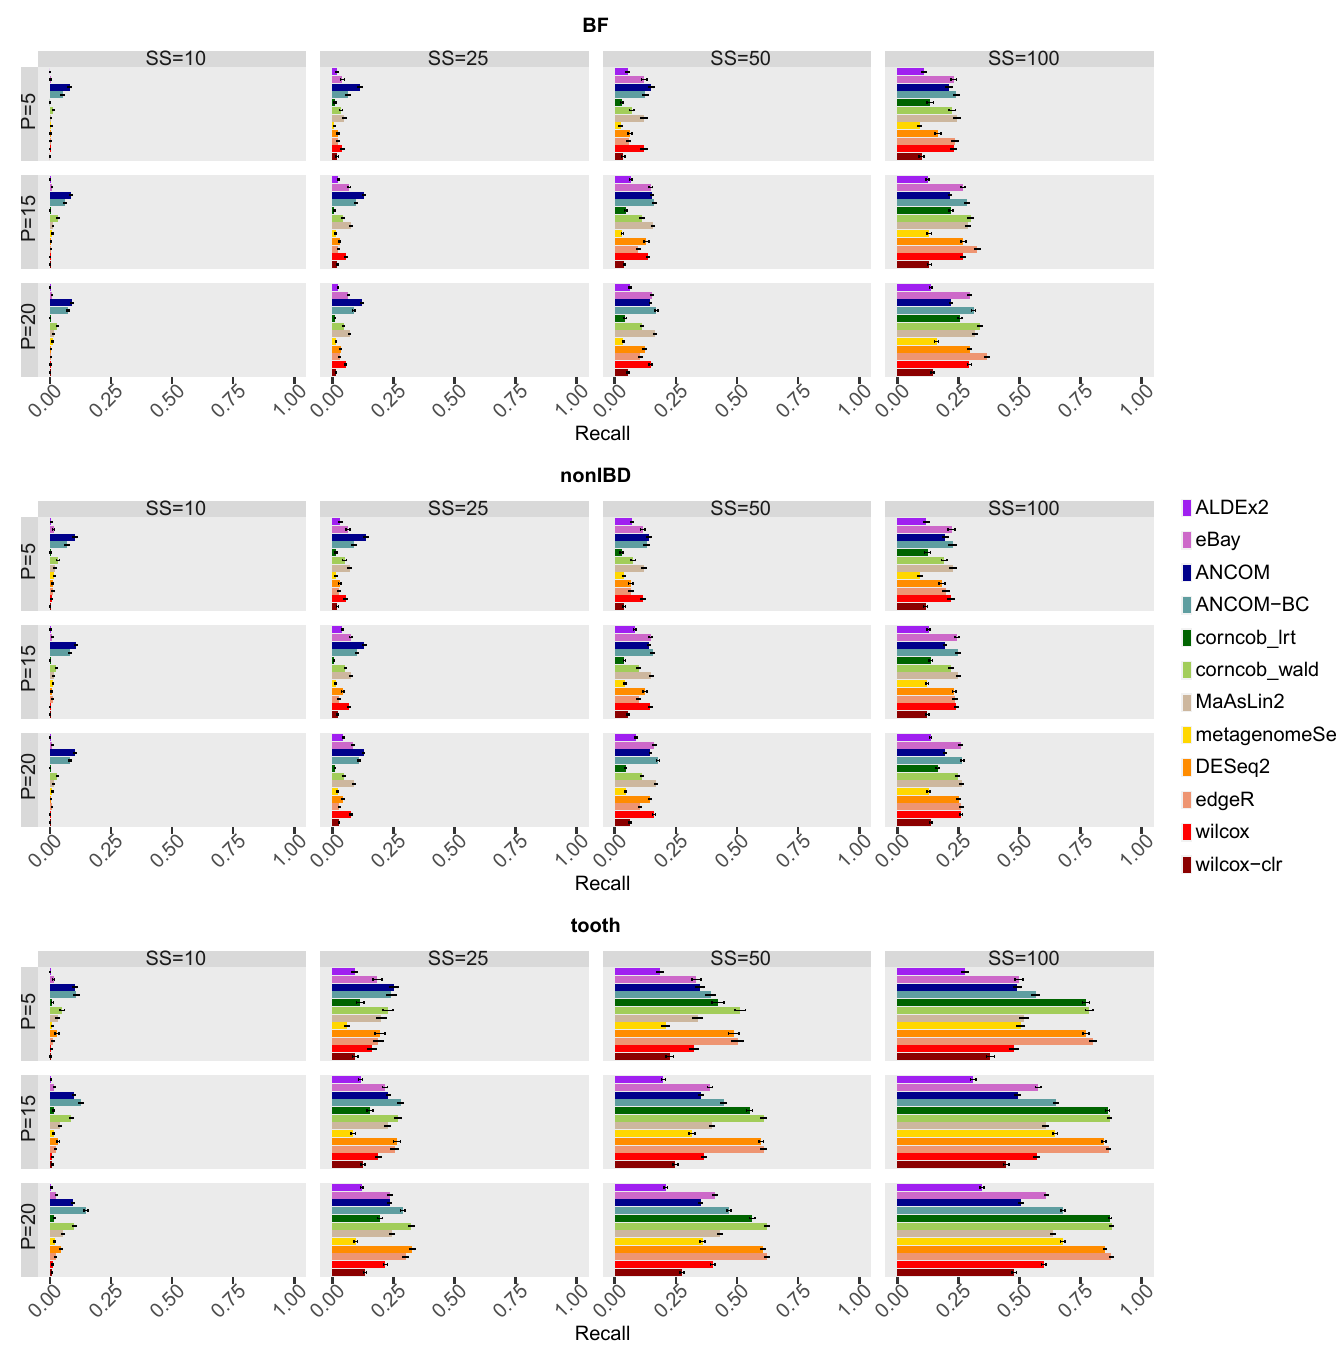
Fig 9. Recall of each differential abundance method for each dataset considered in the comparison in the scenario with simulated DA features and θ = 0. In each set of boxes corresponding to the dataset, different percentages (P) of simulated DA features are on rows, while different sample size (SS) values are on columns. The recall values are averaged over the 50 simulations and the bars show the standard